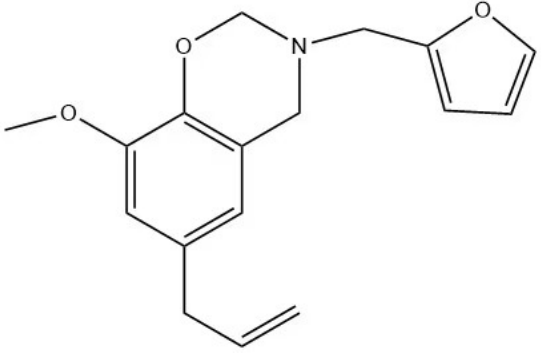
Figure 4. The structure of eugenol–furfurylamine benzoxazine . The FTIR spectrum of benzoxazine (Eugenol) was shown in Figure 5. The results were shown in Table Table 4. The result of FTIR spectrum of benzoxazine (eugenol) [15]. Functional Group Peak